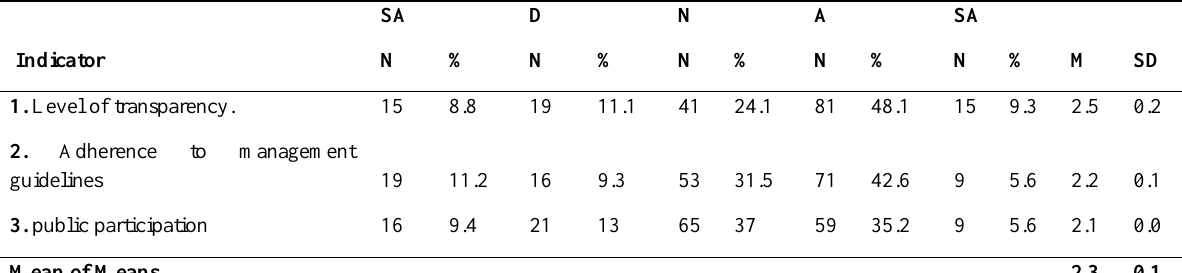
Table 1: Descriptive Analysis- Adherence to Corporate Governance Practices